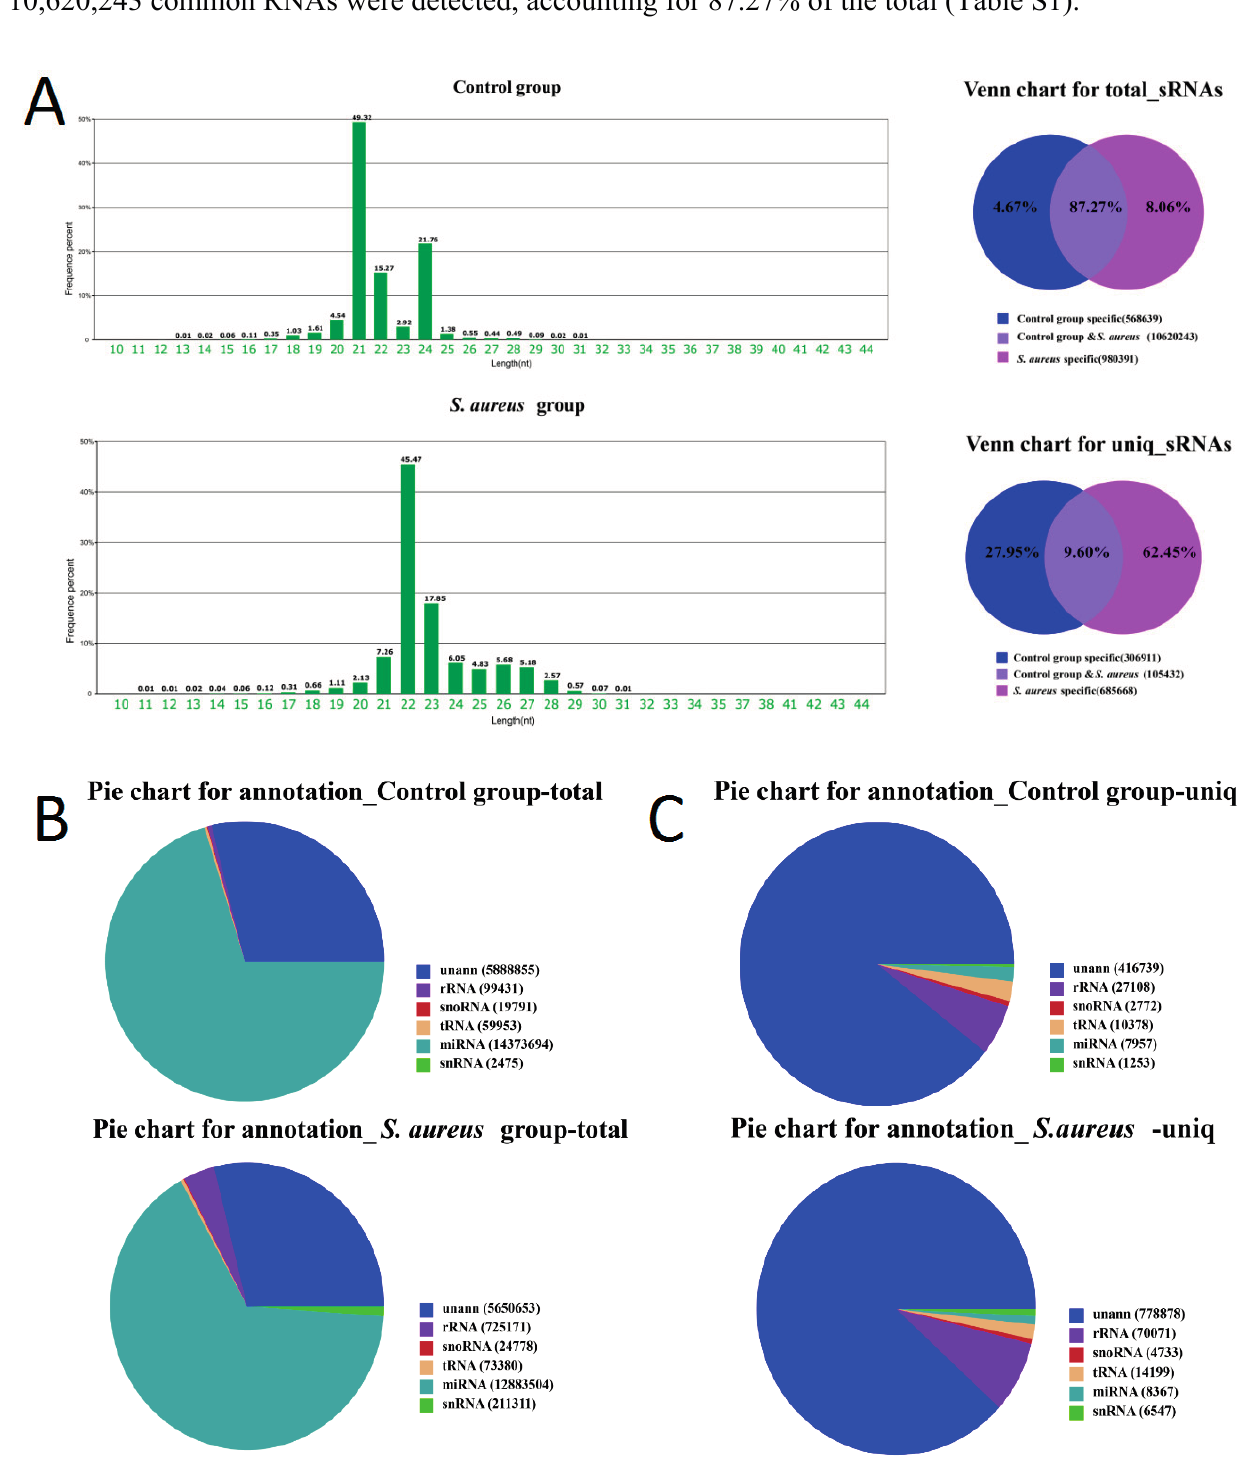
Figure 2. ( A ) Length distribution of two groups of small RNAs; ( B ) Summary of the common and specific tags of two samples; ( C ) Distribution of small RNA among different categories in the control group and S. aureus